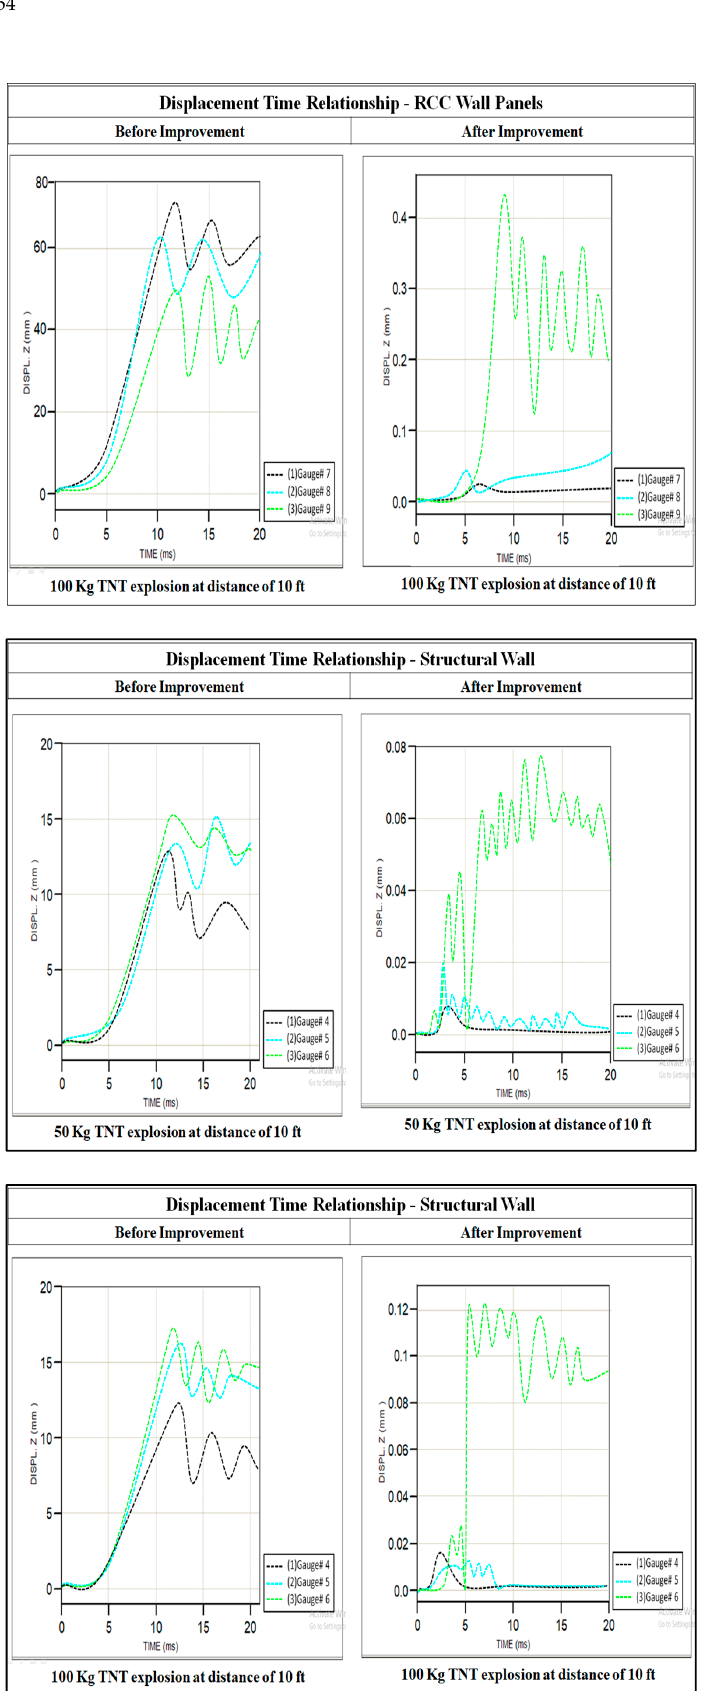
Figure 9. Comparison of TNT explosions at a distance of 10 ft from RCC wall panels.